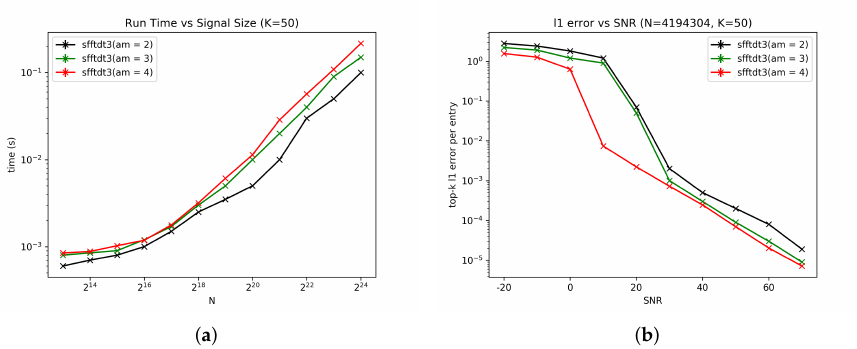
Figure 2. Run time and L 1 -error of sFFT5.0 algorithms using different parameters. ( a ) run time vs. signal size; ( b ) L 1 -error vs. SNR.